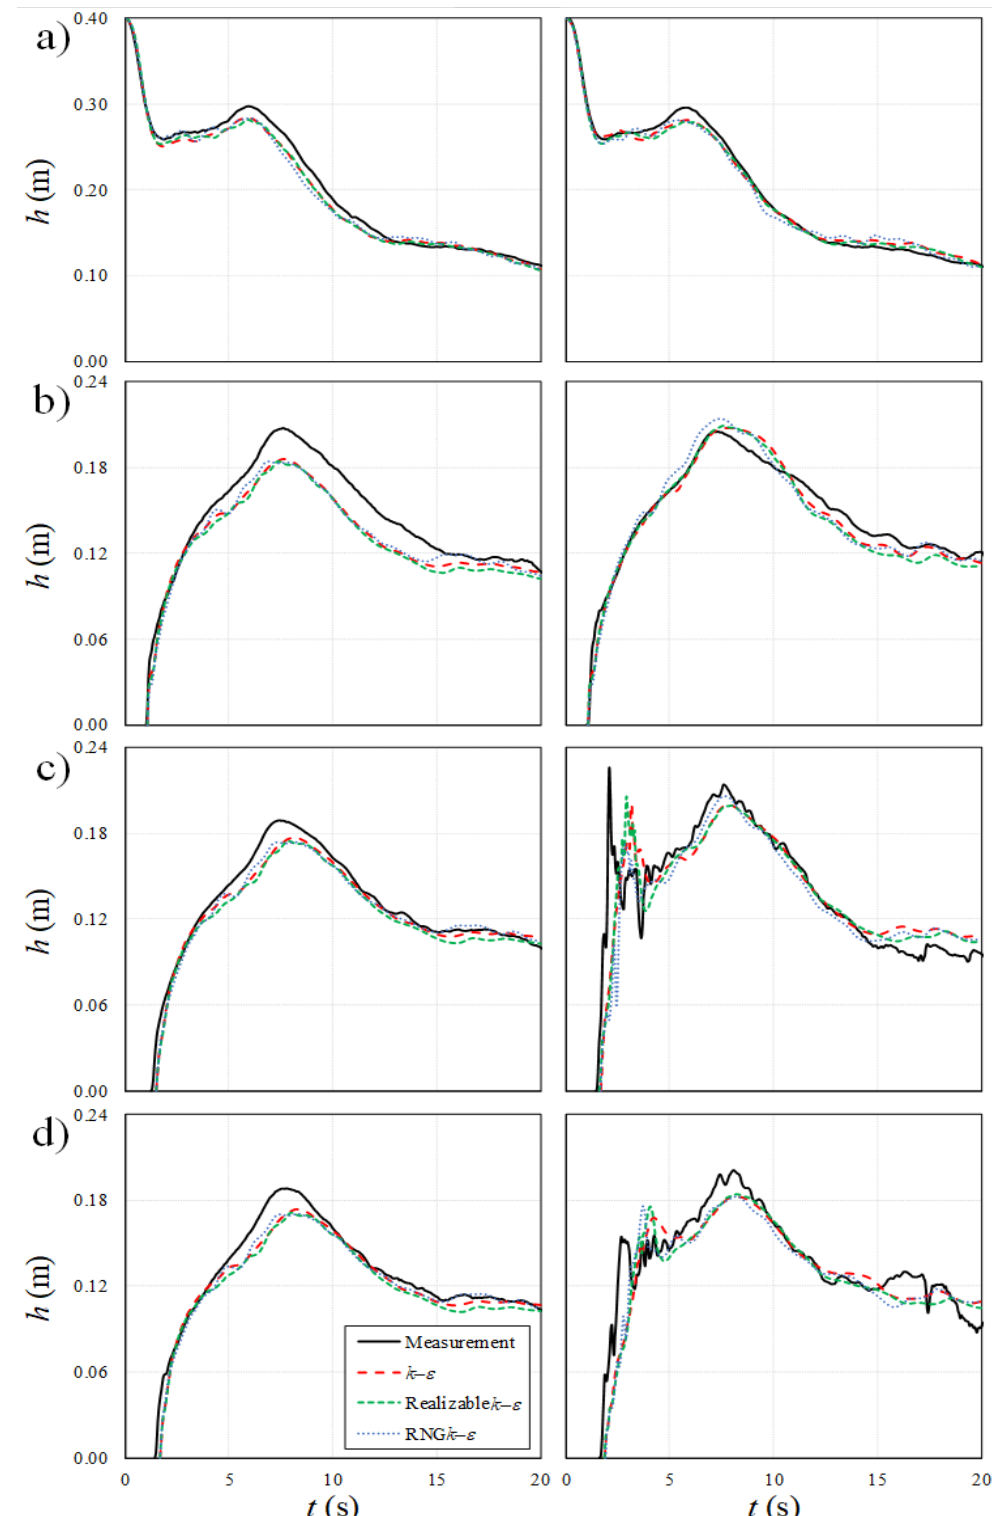
Figure 5. Effect of different turbulence models on the prediction of the time history of the water surface profiles, and comparisons of numerical results with laboratory measurements for d o = 0.4 m. Left column shows the time history of the water surface profiles over the horizontal bed section, while the right column shows the time history of the water surface profiles over a rectangular canal ( w = 0.6 m, d = 0.15 m): ( a ) WG; ( b ) US1; ( c ) US2; ( d ) US3.